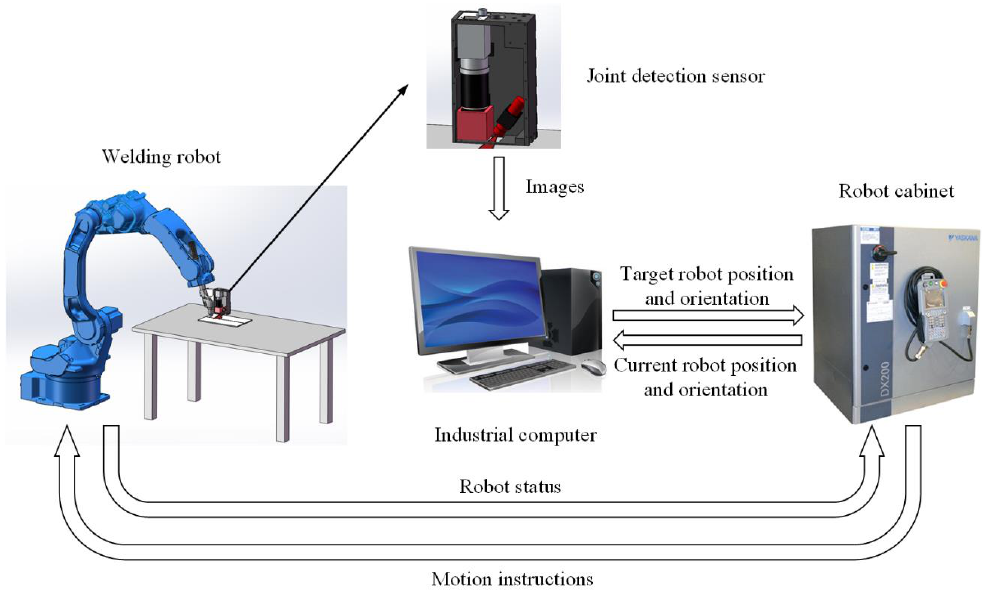
Figure 14. Schematic of the robotic seam tracking system for GTAW (gas tungsten arc welding).